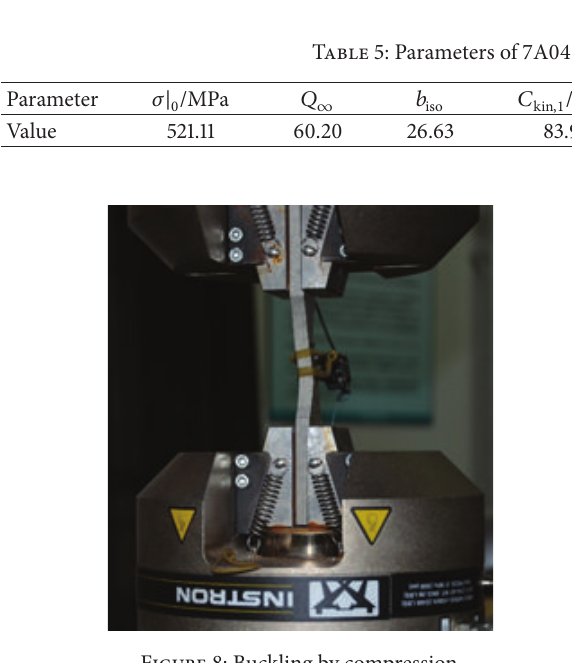
Figure 8: Buckling by compression.